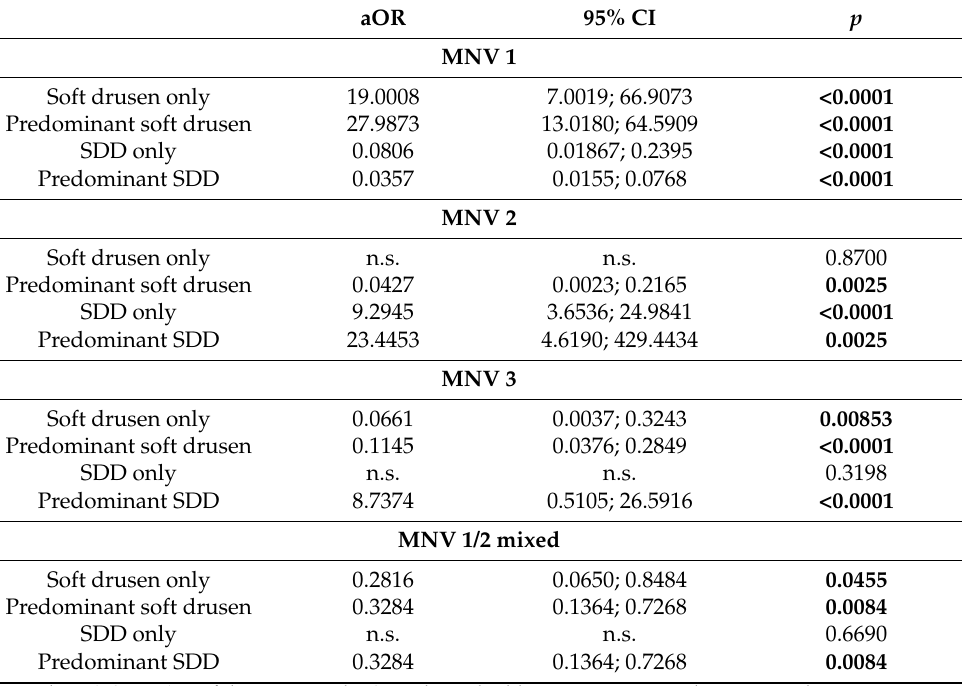
Table 3. Predictors (aOR adjusted for age) between druse and MNV type.